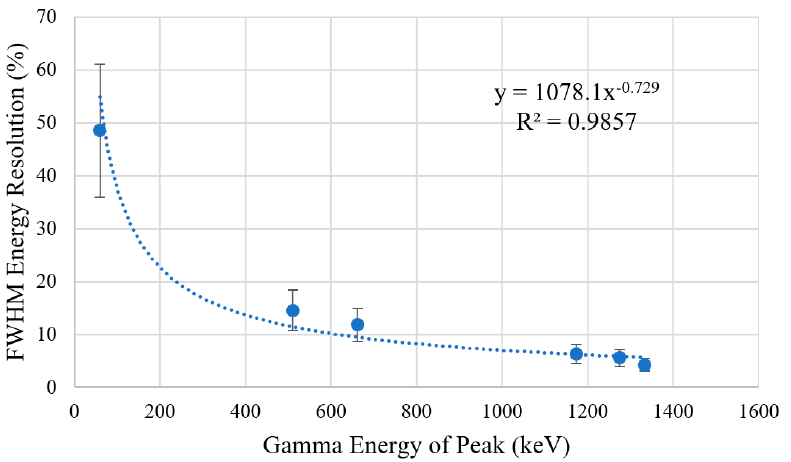
Figure 18. Graph of the energy resolution of the detector with three-sigma error bars. A power trend line has been added to the data alongside a R 2 value for the fi t. From Figure 17, a clear correlation between channel number and energy can be iden- ti fi ed with a linear fi t and an 𝑅 (cid:2870) value of 0.9951. From this, the detector calibration Equa- tion (15) is obtained. 𝐶ℎ𝑎𝑛𝑛𝑒𝑙 𝐸𝑛𝑒𝑟𝑔𝑦 (𝑘𝑒𝑉) = 0.6482 × 𝐶ℎ𝑎𝑛𝑛𝑒𝑙 𝑁𝑢𝑚𝑏𝑒𝑟 − 56.078